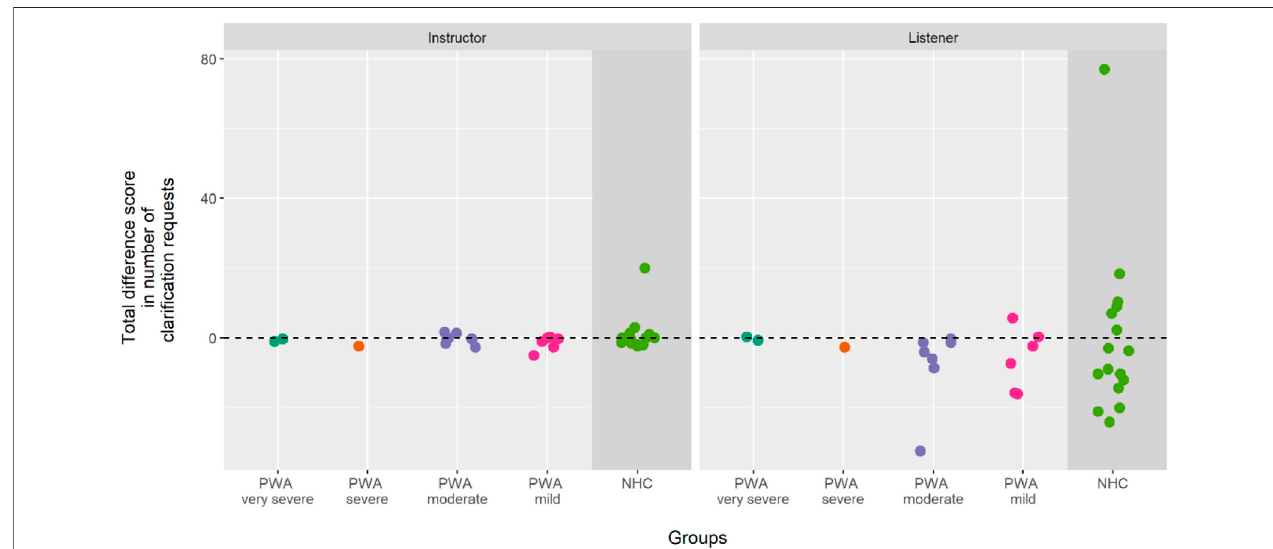
FIGURE 10 | Plot showing individual data points for PWA for difference score between familiar and unfamiliar conditions, by role, categorized by WAB categorization. Zero representsno change in thenumber ofclari fi cation requestsbetween conditions, negative valuesindicate asmallernumber ofclari fi cation requests in the unfamiliar condition compared to the familiar